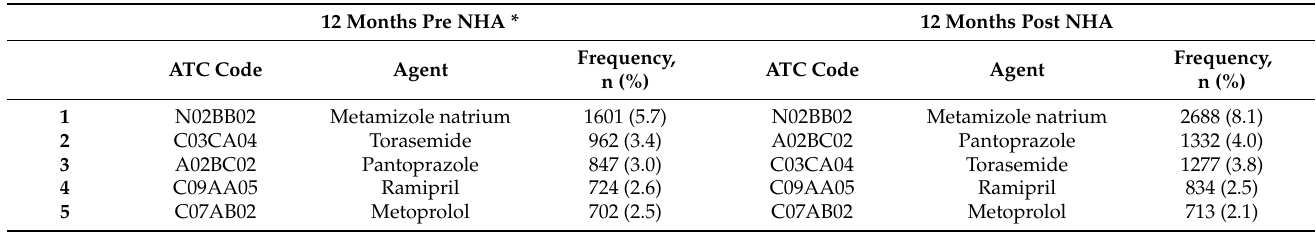
Table 6. Top five most prescribed drugs in percentage of all prescriptions in the year prior vs. after nursing home admission (NHA) in patients with psoriasis (N = 718).